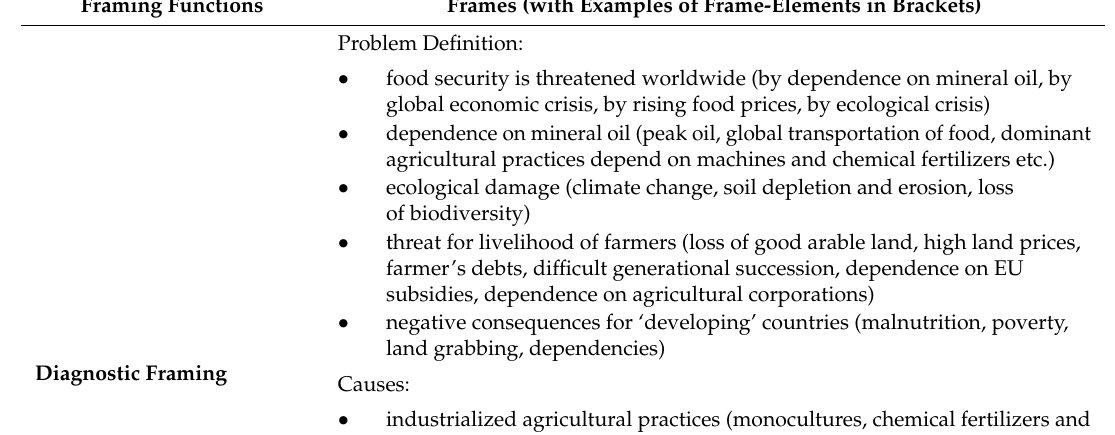
Table A2. Framing in the film Voices of Transition